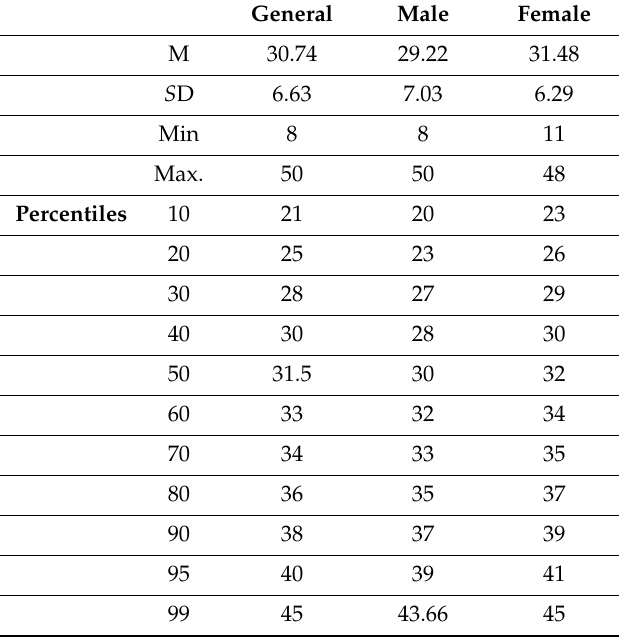
Table 5. Scales for general population and by